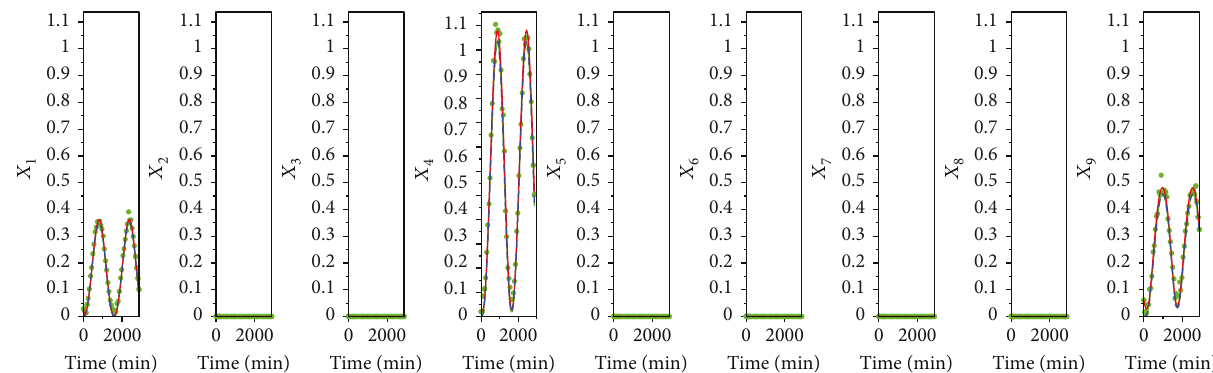
− 1 ). The Figure 4: Dynamics of the toy network represented in Figure 3. The functions X i represent the metabolite concentrations in units (g · L numerical solution of the original system (9) is depicted by the green line; the reduced system obtained by the method exposed in this work (71), by the blue dashed line; the supposed data with white noise (73), by green points; and the calibrated system (62) – (66) with the estimated parameters in Table 1 and Table 2, by the red line. The parameters considered are in Table 3 and Table 4. As expected, the concentrations of the metabolites in QSS are one order of magnitude ε lower than those of the metabolites in the slow part. Table 1: Parameter estimation for system (71), rewritten as (62). The estimation of these parameters only requires the slow dynamics of the toy network in Figure 3.